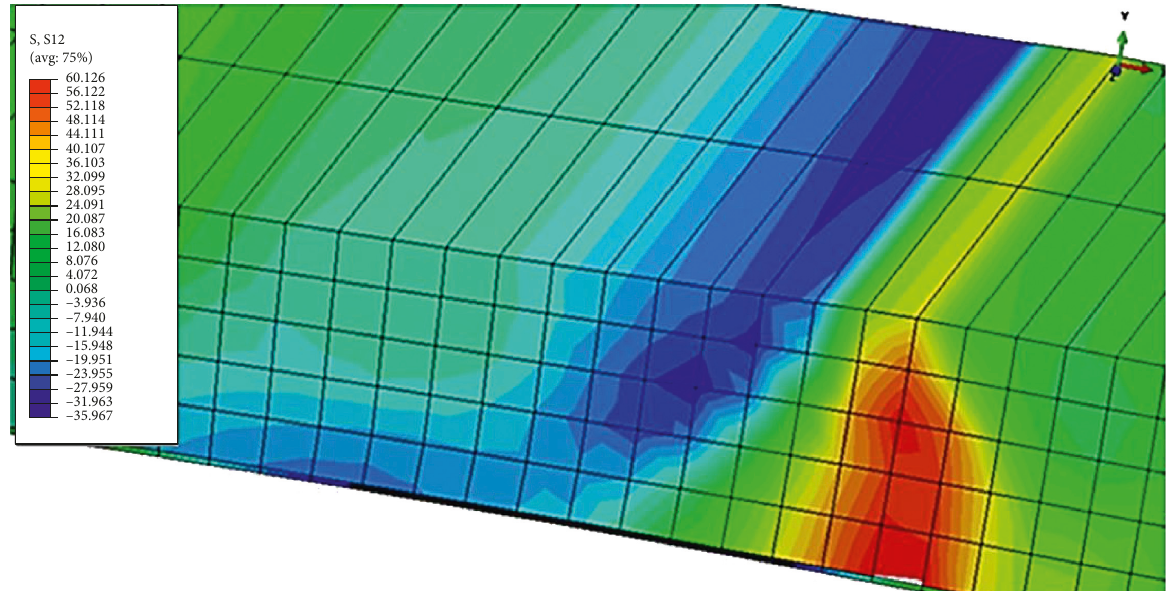
Figure 19: The distribution of tangential contact stresses in a thermal deformation hearth at K